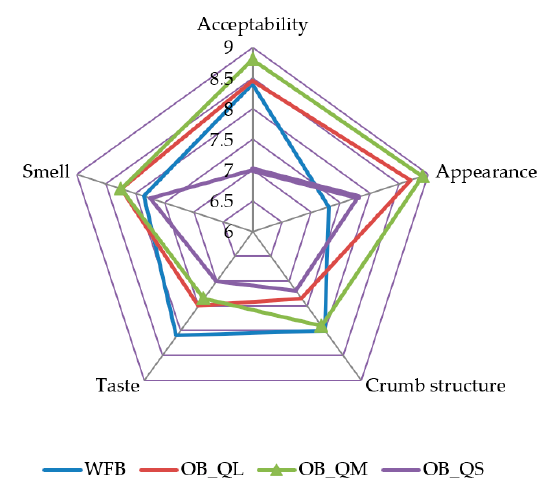
Figure 5. Sensory characteristics of bread samples with the optimal dose of quinoa flour addition corresponding to the large, medium, and small particle size (OB_QL, OB_QM, and OB_QS) versus wheat flour bread (WFB).